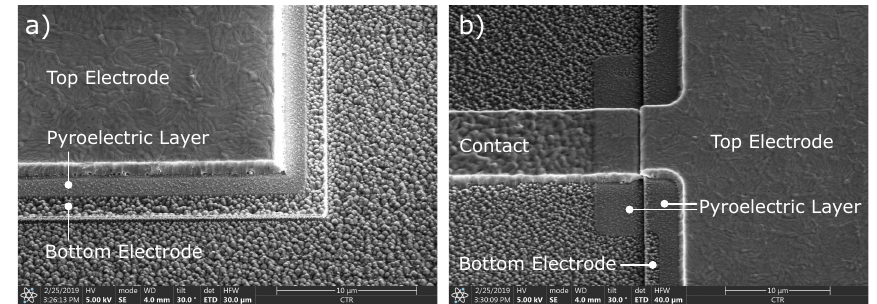
Figure 4. SEM micrograph of a fabricated detector. ( a ) The bottom-right part of the detector, depicting the different layers, the bottom electrode (doped-Si), the pyroelectric layer (AlN) and the top electrode (AlSiCu) of the detector. Due to difficulties of the AlN patterning, the bottom electrode is covered with grainy residues of AlN. ( b ) the most left-middle part of the detector, depicting how the top electrode is contacted.